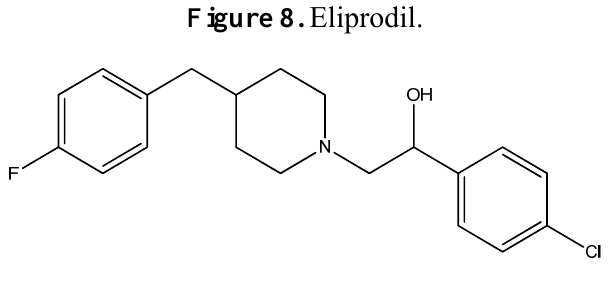
Figure 9. 5,7-Dichlorokynurenic